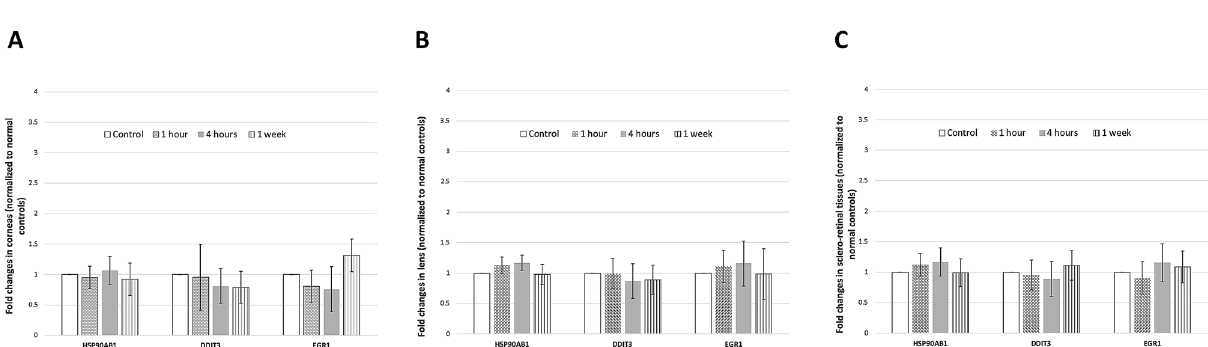
Figure 11. Gene expression in corneas ( A ), lens ( B ) and sclero-retinal tissues ( C ) measured for different groups using qRT-PCR. The mRNA expression fold values (2 −ΔΔCT ) were measured and normalized to that of the control group. There were no significant changes in the expression of HSP90AB1, DDIT3 and EGR1 in all the exposure